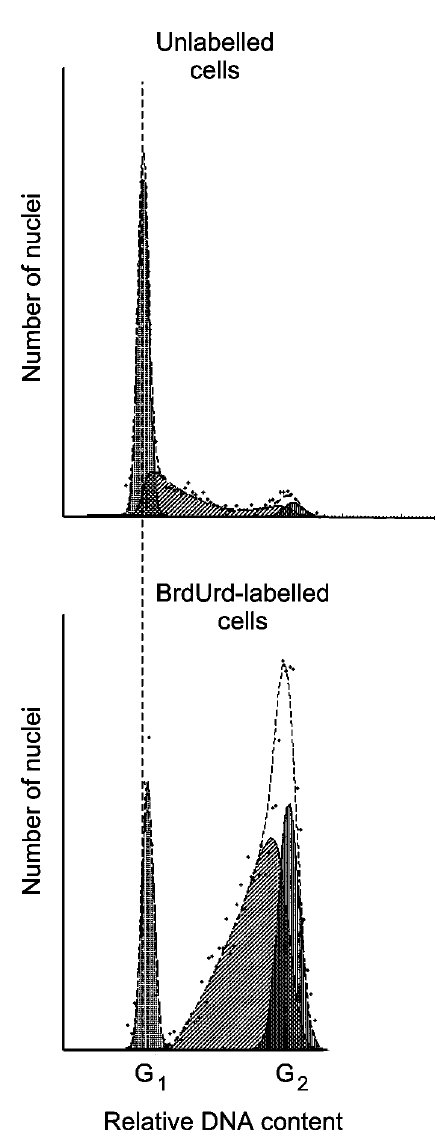
Fig. 2. DNA histograms of unlabelled and BrdUrd-labelled cells from one cell population of MCF-7 cells. MCF-7 cells were labelled with 5 (cid:22) M BrdUrd for 30 min and then allowed to progress through the cell cycle for 8 hours before fixation and processing to detect Br- dUrd and DNA contents with FCM. Unlabelled and BrdUrd-labelled cells were distinguished in the DNA versus BrdUrd cytogram be- fore each cell population was displayed as a histogram. The line is drawn through the mean DNA content of unlabelled G 1 phase cells. The ratio between the mean DNA content of BrdUrd-labelled G 1 phase cells and that of unlabelled G 1 phase cells was 1 : 03 (cid:6) 0 : 001 ( n =